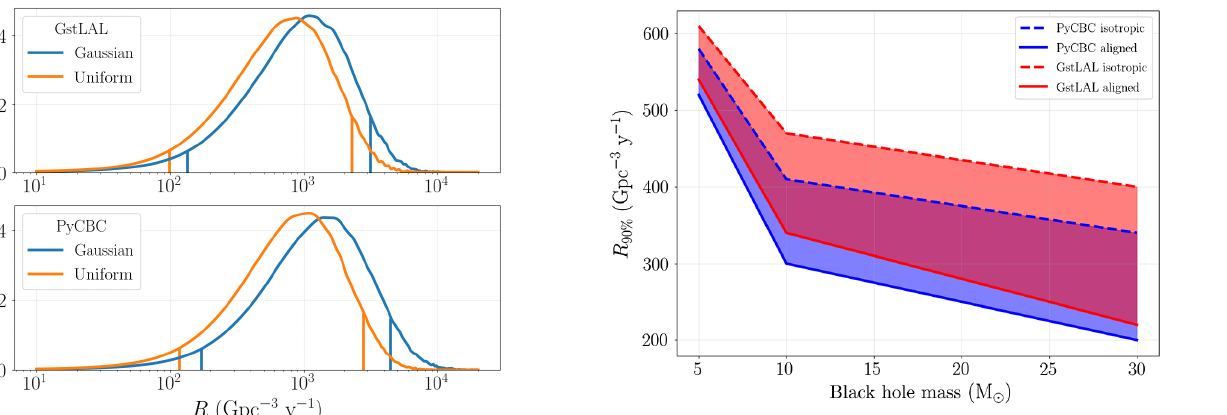
FIG. 13. This figure shows the posterior distributions of the BNS event rate for the GstLAL and PyCBC searches. The uniform mass distribution corresponds to the orange curves, and Gaussian mass distributions correspond to the blue curves. The symmetric 90% confidence intervals are indicated with vertical lines beneath the posterior distributions.